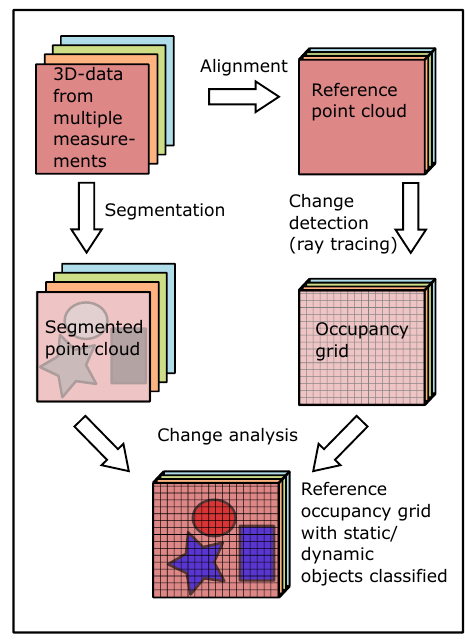
Figure 5. The four main steps of our change detection method: alignment, segmentation, change detection and change analysis.